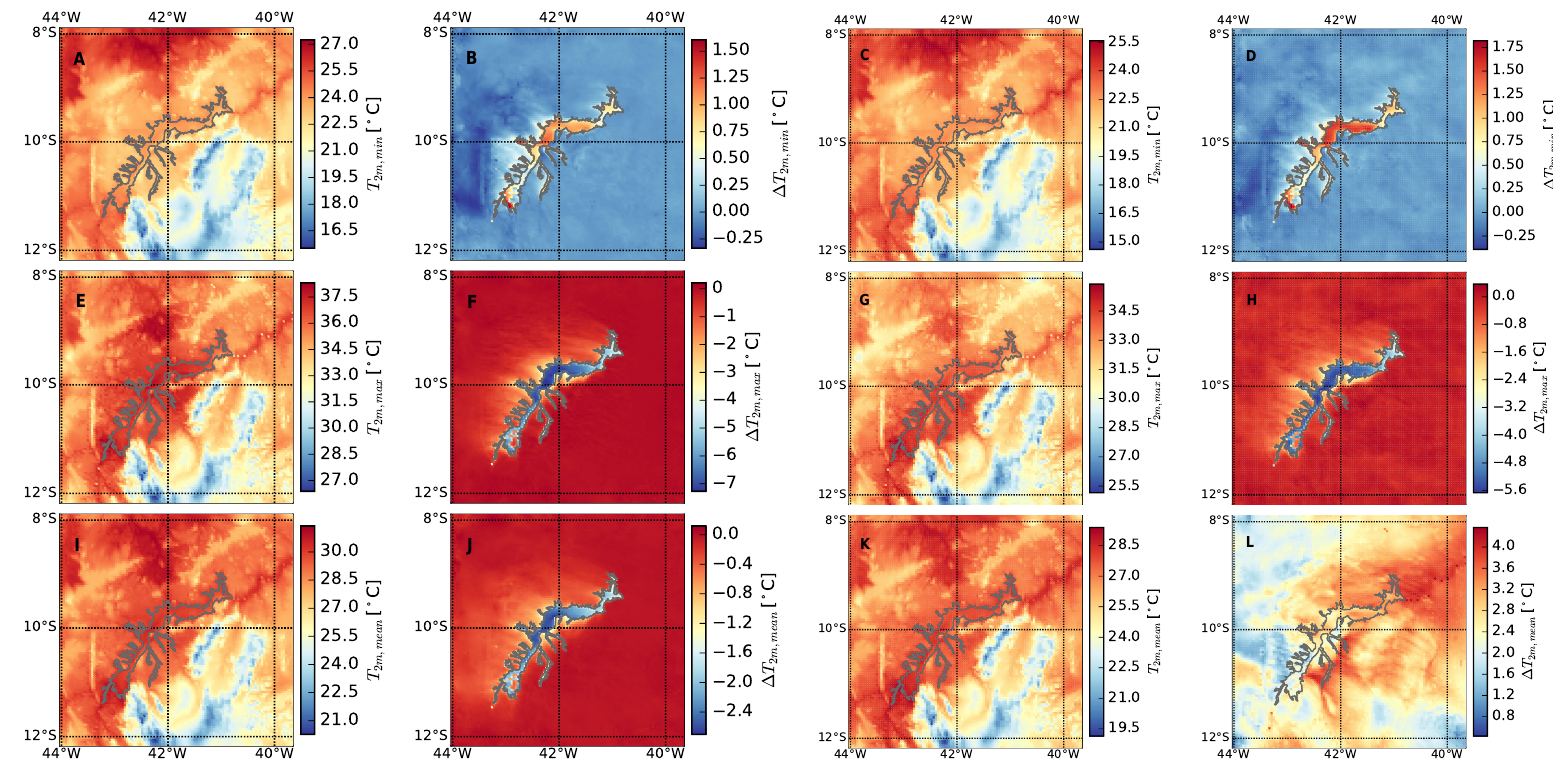
Figure 4. Simulated air temperatures at 2m above ground: ( A , B , C , D ) daily minimum, ( E , F , G , H ) daily maximum and ( I , J , K , L ) daily mean values for the periods ( A , B , E , F , I , J ) 1 April–31 May 1998 and ( C , D , G , H , K , L ) 1 April–31 May 2002, respectively. ( A , C , E , G , I , K ) Results for simulations without the lake; ( B , D , F , H , J , L ) differences between the results including the lake with respect to the control runs without the lake. The lake’s position is indicated by gray